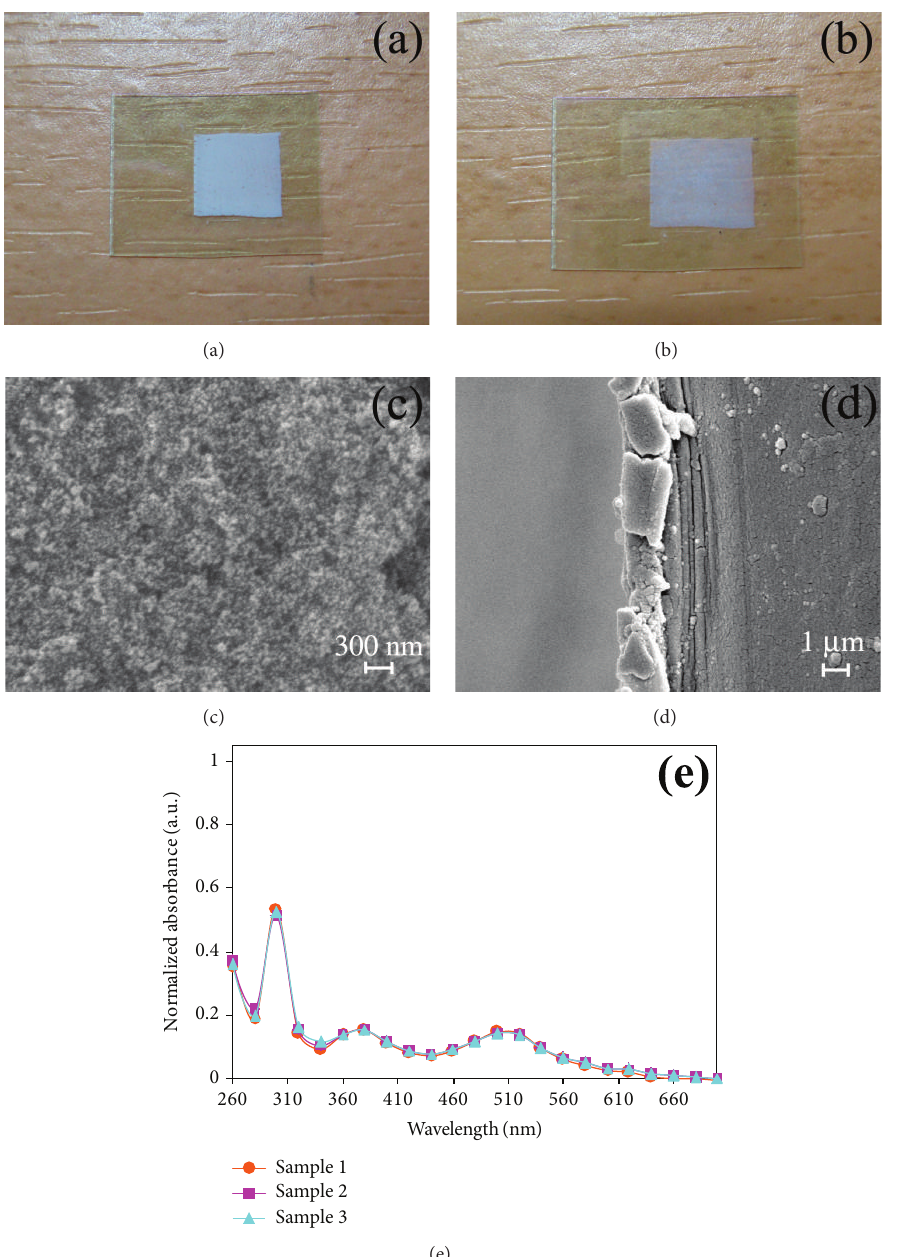
Figure 7: The optical image of (a) the unpressed TiO 2 /ITO/PEN film and (b) the pressed TiO 2 /ITO/PEN film. (c) The top and (d) cross section SEM images of the pressed TiO 2 /ITO/PEN film. (e) Absorbance spectra of the desorbed dye solutions of the pressed TiO 2 /ITO/PEN